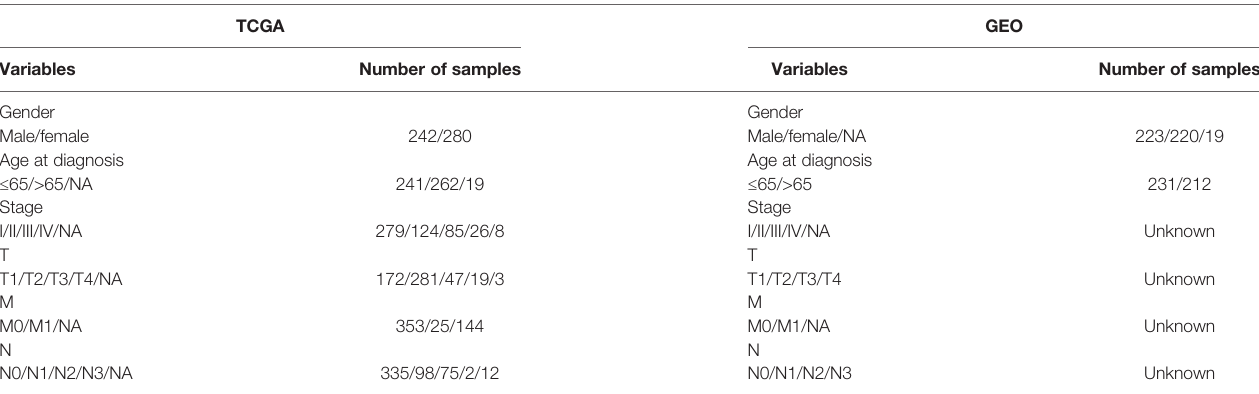
TABLE 1 | The clinical characteristics of